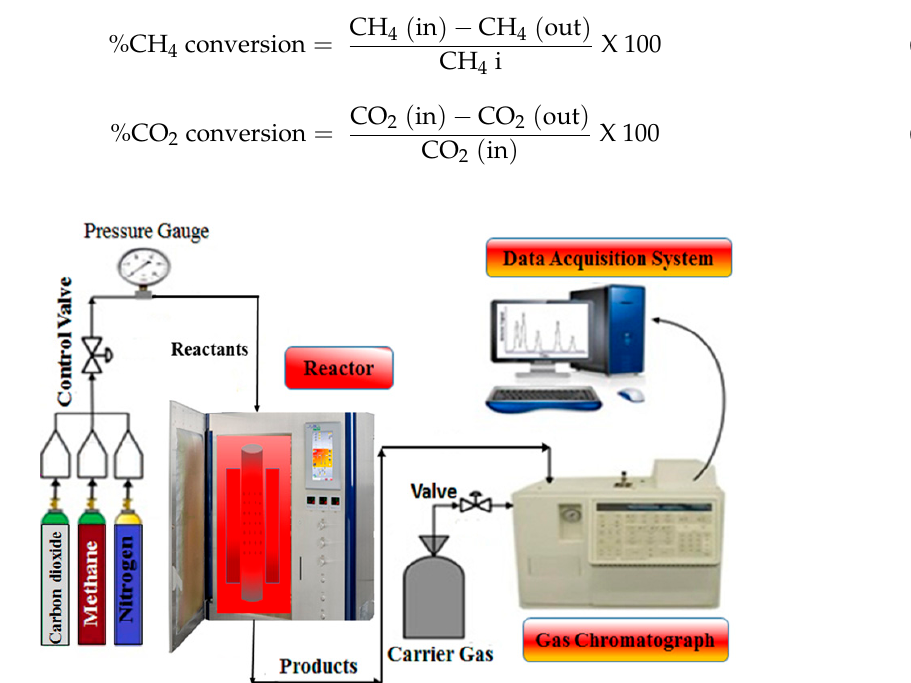
Figure 12. Schematic diagram of experimental setup for dry reforming of methane.